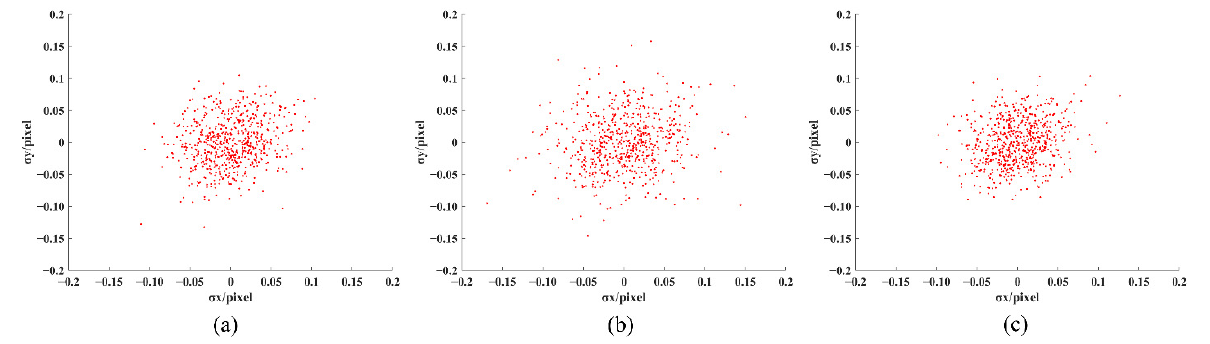
Figure 13. Reprojection-error scatter plot: ( a ) Literature [36] algorithm, ( b ) MATLAB Toolbox, and ( c ) Our algorithm.